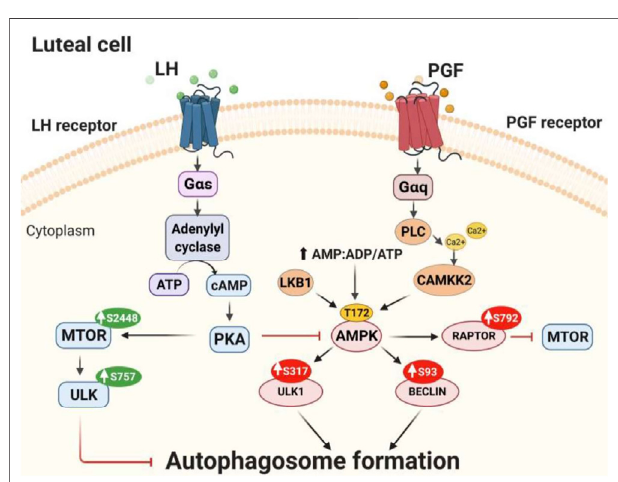
FIGURE 11 | Proposed model of LH/PKA/MTOR and PGF2 α /AMPK signaling in luteal cells. LH binds to G-protein coupled receptors present on thesurfaceoflutealcellsleadingtoincreasedactivityofproteinkinaseA(PKA). LH/PKA increases the phosphorylation at Ser2448 (S2448) and activity of MTOR. Active MTOR phosphorylates ULK1 at Ser757 leading to its inactivation and preventing autophagosome initiation. Simultaneously, LH reduces phosphorylation of AMPK α at Thr172 (T172) and RPTOR at Ser792 (S792) maintainingMTORactivity and preventingautophagyinduction.AMPK can be triggered by PGF2 α or other stimuli that mobilize calcium or disrupt luteal metabolism. AMPK is activated by phosphorylation at Thr172 by upstream kinases [Calcium/Calmodulin-Dependent Protein Kinase Kinase 2 (CAMKK β ), Liver Kinase B1 (LKB1)] or by increased ratio of AMP/ATP. Activated AMPK phosphorylates RPTOR at Ser792 and inhibits MTOR activity. Active AMPK also phosphorylates ULK1 at Ser317 and BECN1 at Ser93 leading to autophagosome formation and autophagy in the corpus